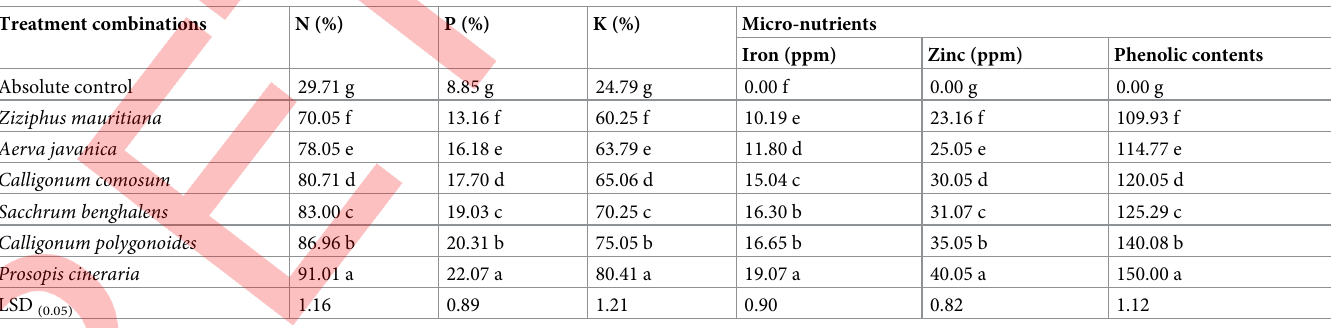
Table 5. The impact of different vermicompost treatments on the uptake of macro a d micronutrients. Treatment combinations